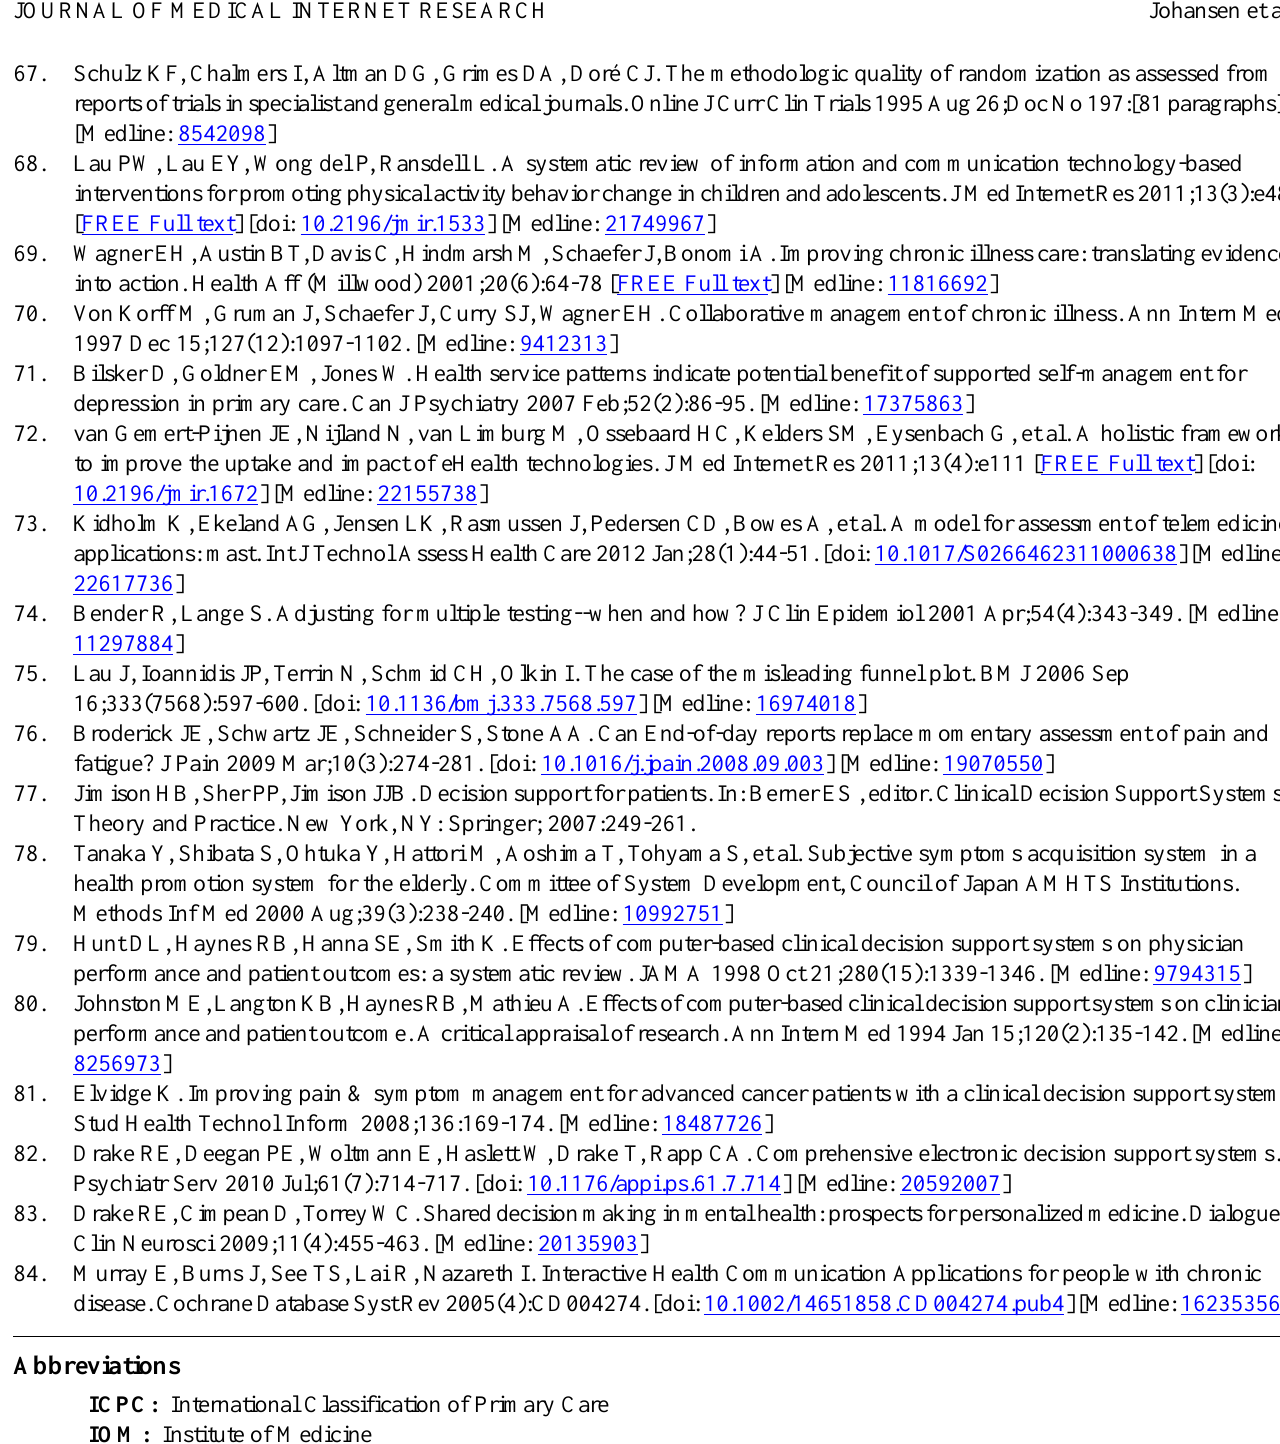
ICPC: International Classification of Primary Care IOM: Institute of Medicine PRISMA: Preferred Reporting Items for Systematic Reviews and Meta-analyses RCT: Randomized Controlled